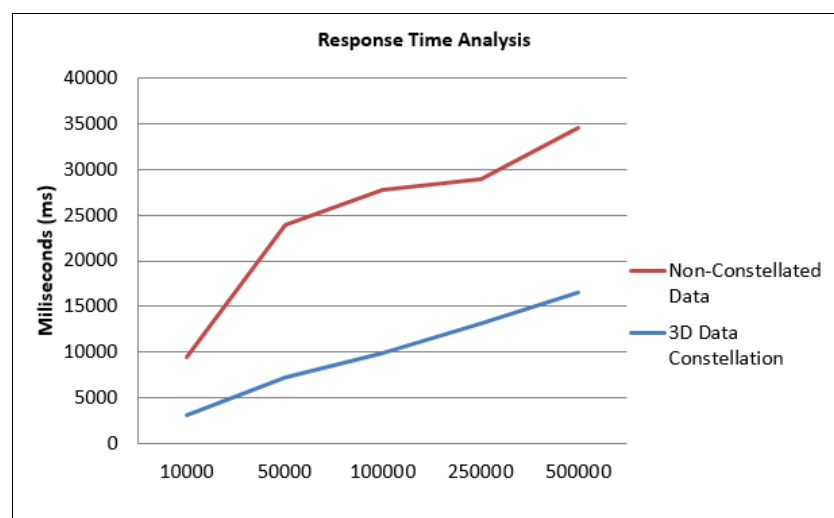
Figure 7. Response time analysis for k number of objects